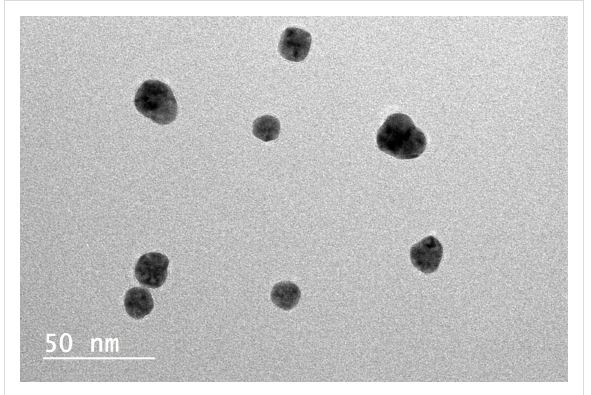
Figure 1: Typical TEM image of Au NPs before thermal